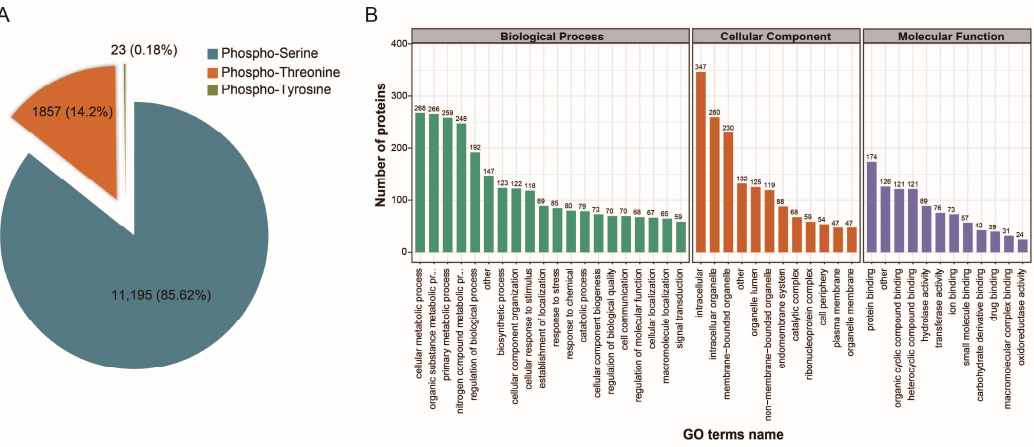
Figure 1. ( A ) Distribution of phosphorylation on serine (pSer), threonine (pThr), and tyrosine (pTyr) for all phosphorylation sites. ( B ) Functional classification of phosphorylated proteins.